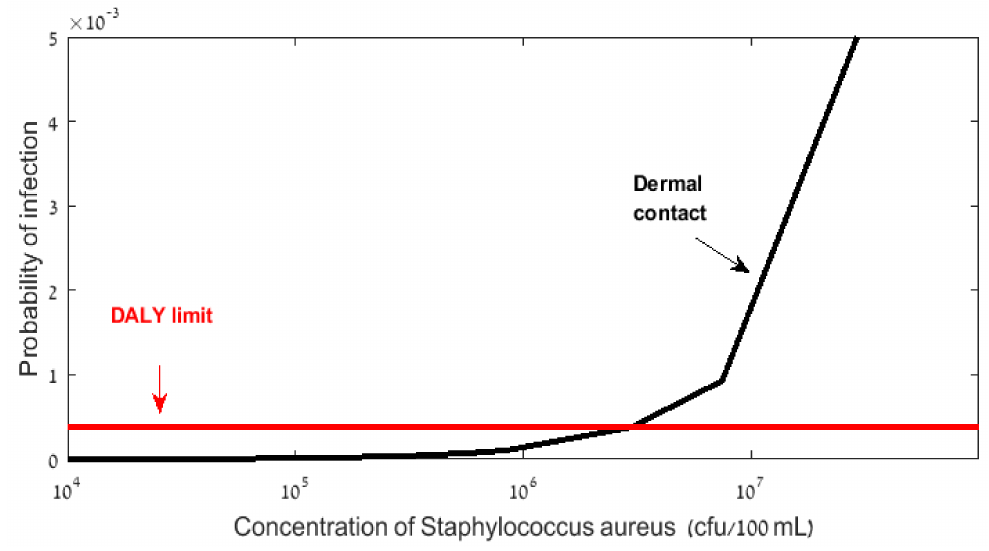
Figure 3. Probability of skin infection from worst-case exposure to Staphylococcus aureus due to accidentally washing hands in greywater. The red solid horizontal line represents the DALY limit of acceptable risk as suggested by the WHO